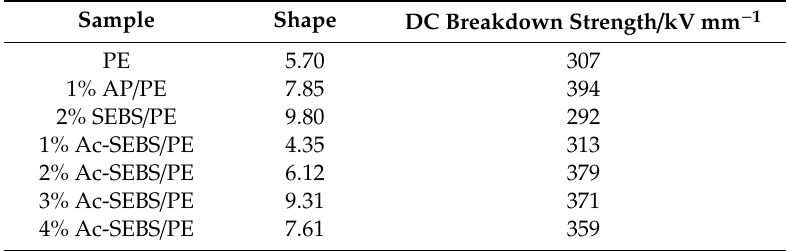
Figure 7. Weibull plots of the DC breakdown strength of Ac-SEBS/PE with different contents of Ac-SEBS. Table 3. DC characteristic breakdown strength and shape parameter of different Ac-SEBS contents.